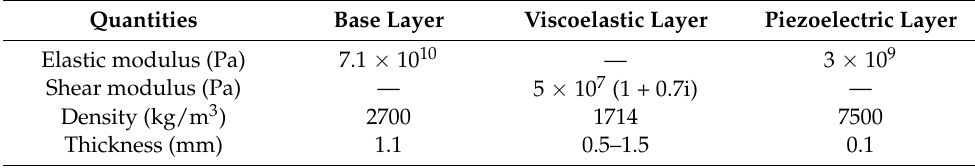
Table 2. The materials and properties of each layers.